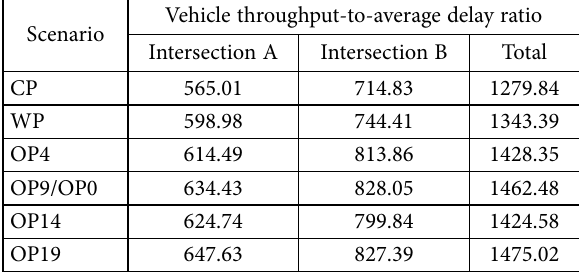
Table 7. Intersection performance measures for seven simulated